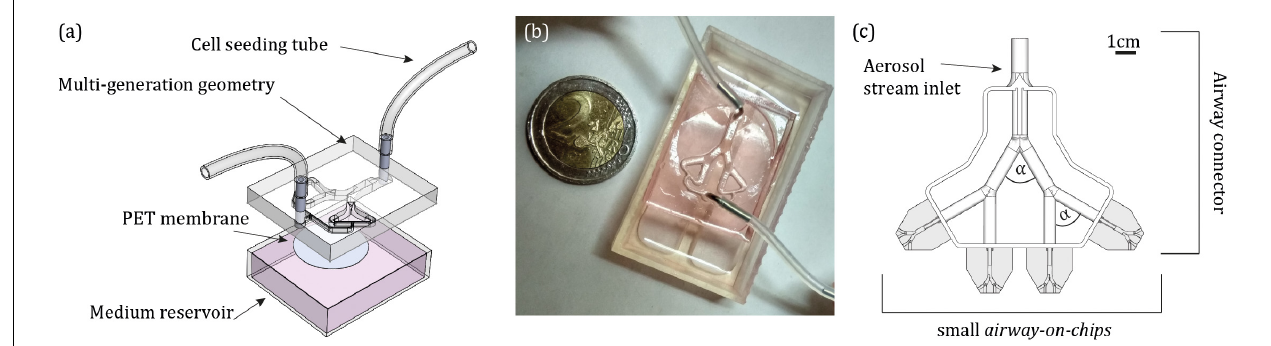
FIGURE 1 | Design of the airway-on-chip platform and its integration for aerosol inhalation exposure assays. (a) Computer-aided drawing (CAD) schematic of the device including the airway tree model (apical side), a porous PET membrane (gray circle) separating the bottom reservoir for medium (basal side). (b) Photograph of the assembled device. (c) CAD schematic of the custom-designed 3D airway tree connector which allows to simultaneously perform experiments across four individual airway-on-chip devices (shown in gray), and control the orientation of gravity during an exposure assay, with bifurcating angle of α = 60 ◦ ( Supplementary Figure S1 ).